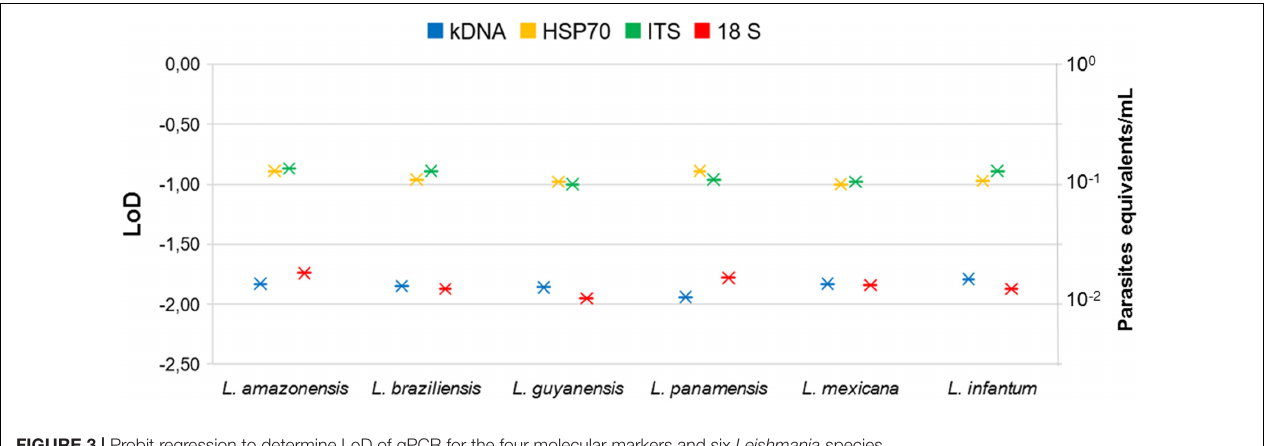
FIGURE 3 | Probit regression to determine LoD of qPCR for the four molecular markers and six Leishmania species. TABLE 1 | Comparison of the LoD in terms of means, standard deviation, coefficient of variation percentage as a measure of accuracy of the 6 species of Leishmania for each molecular marker by qPCR.